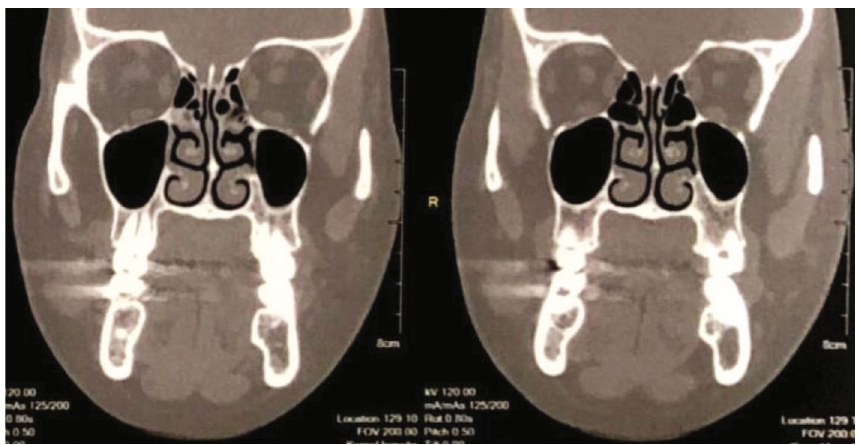
Figure 2: Coronal MDCT image shows a circular well-de fi ned homogenous mass in the right buccal